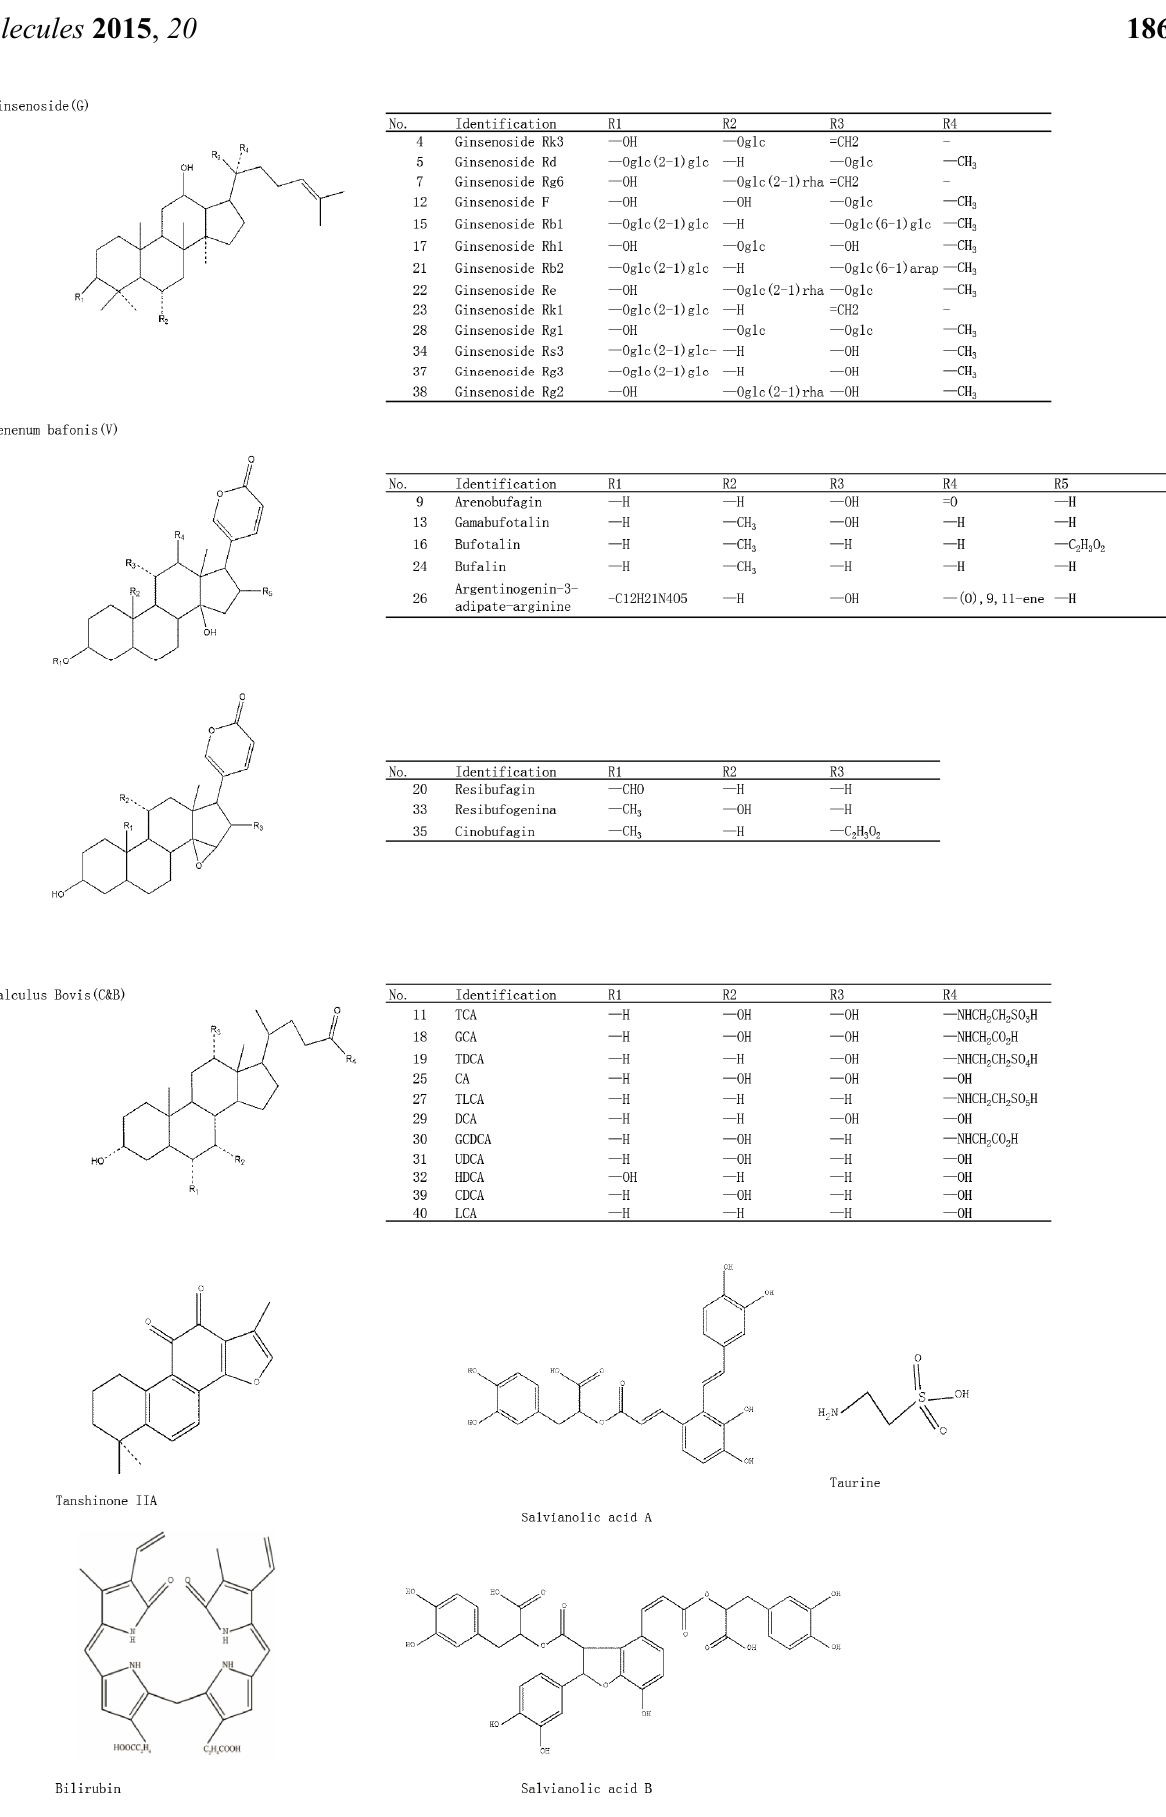
Figure 2. Chemical structures of the compounds identified in